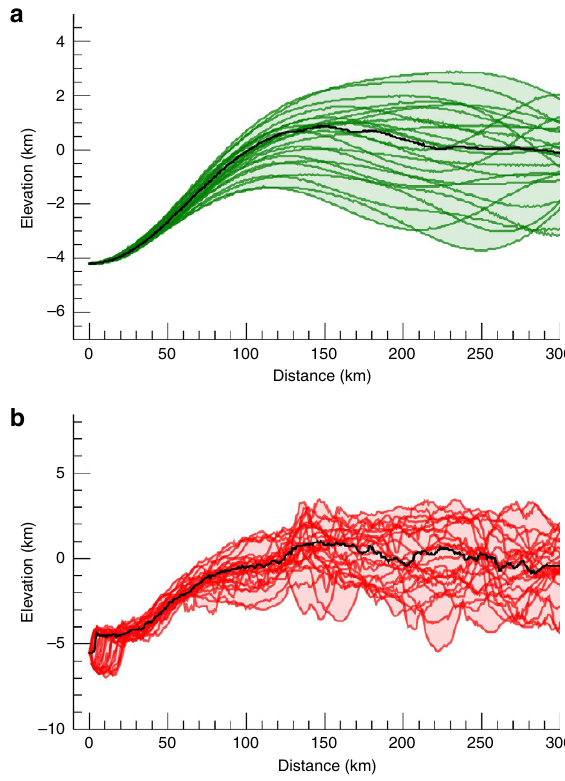
Figure 6 | Kerwan crater’s topographic profiles. ( a ) Filtered topography, ( b ) real topography. Black lines are the median of the profiles. Elevations are computed with respect to the 482 (cid:3) 482 (cid:3) 446km ellipsoid 7,16 . Distance is computed along the surface of the best ellipsoid. Topographic profiles are for increments of 15 (cid:2) in azimuth starting from the centre of the